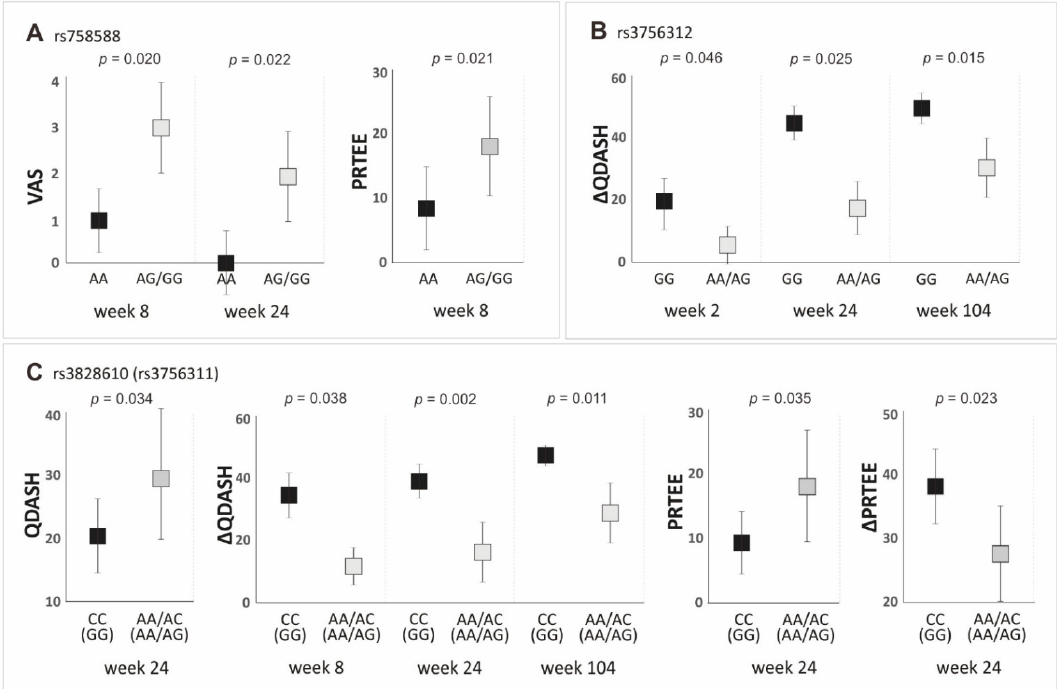
Figure 5. Medians (± QD) of PROMs values with respect to genotype variants of the PDGFRB gene polymorphisms in the dominant/recessive model: ( A ) for VAS (weeks 8 and 24) and PRTEE (week 8), for rs758588 SNP; ( B ) for Δ QDASH (weeks 2, 24, and 104), for rs3756312 SNP; ( C ) for QDASH (week 24), Δ QDASH (weeks 8, 24, and 104), PRTEE (week 24) and Δ PRTEE (week 24), for rs3828610 and rs3756311 SNPs.